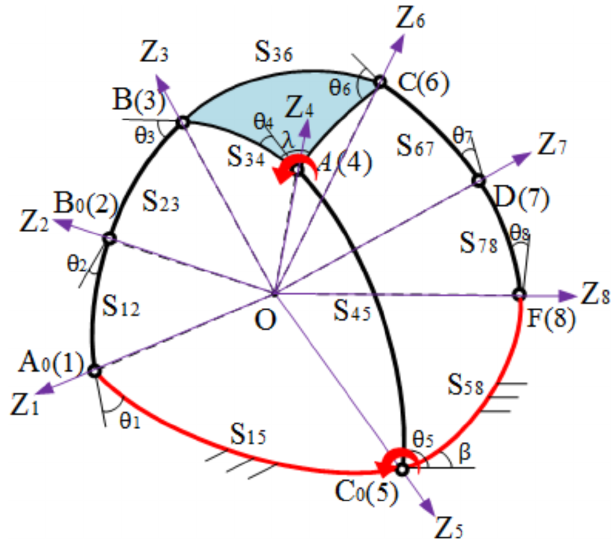
Figure 1. The 2 DOF seven-bar spherical parallel manipulator with only R